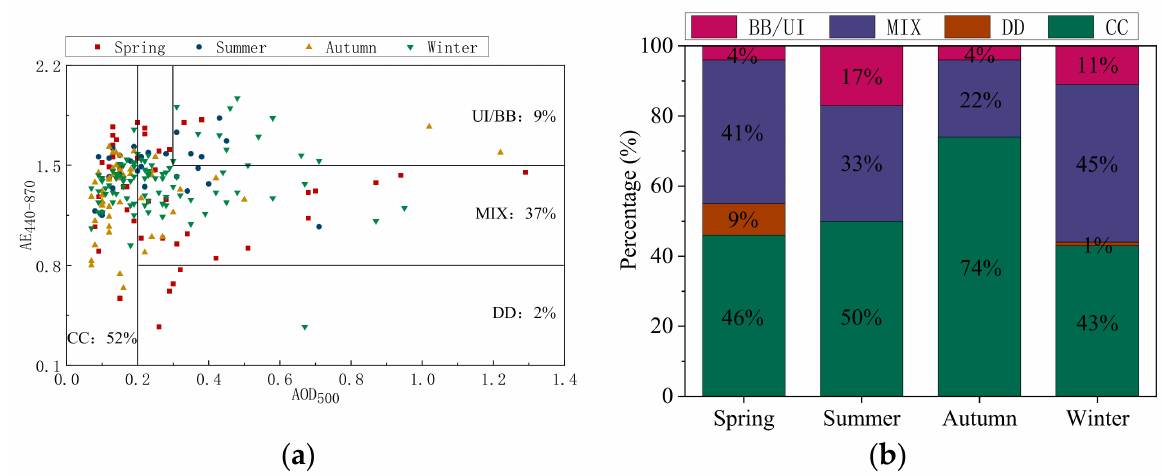
Figure 4. ( a ) The scatter plot of the daily mean and as well as the total percentage of aerosol types during the year, ( b ) the percentage of various aerosol types during different seasons.